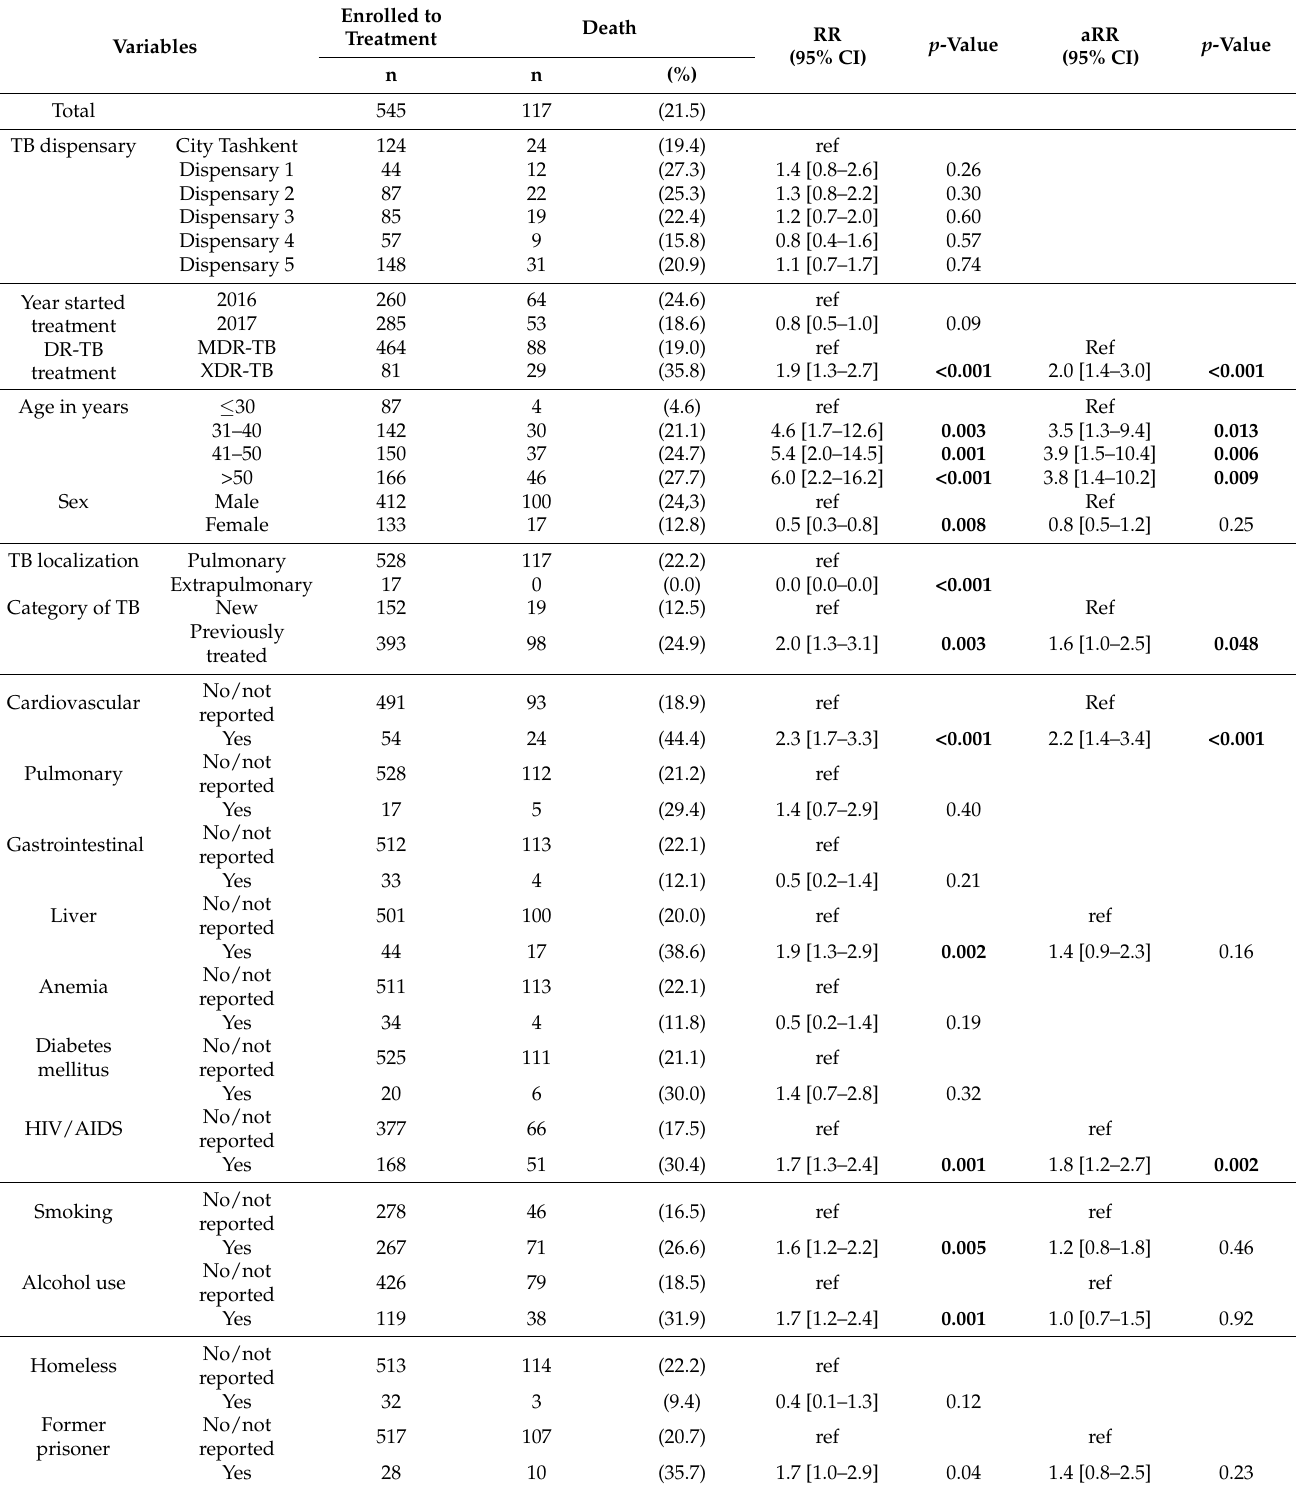
Table 4. Risk factors for death in persons with TB enrolled for MDR-TB and XDR-TB treatment in Tashkent city, Uzbekistan,